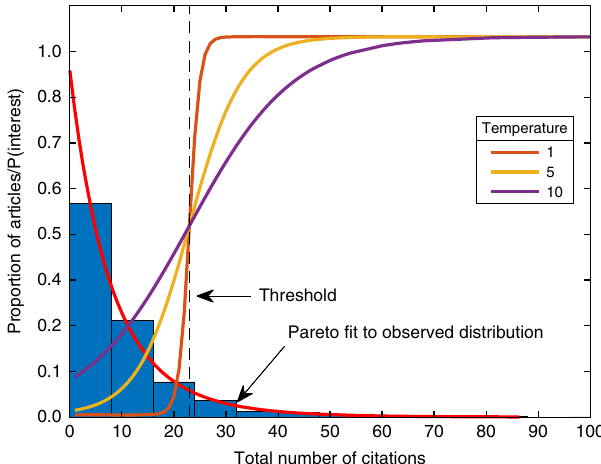
Fig. 2 Distribution of citations for articles published in psychology. The blue histogram shows observed distribution of citations for all articles published in 2014. The best- fi tting Pareto distribution is represented by the solid red line. The threshold centered on the 90th percentile of the fi tted distribution is indicated by the vertical dashed line. The three logistic functions are centered on the threshold but have different temperatures (see legend). They determine the probability of the scienti fi c community fi nding a phenomenon to be of interest. In the simulation, each fi nding is associated with a random draw from the best- fi tting Pareto distribution, which is then converted into a probability of interest using the appropriate logistic decision function.